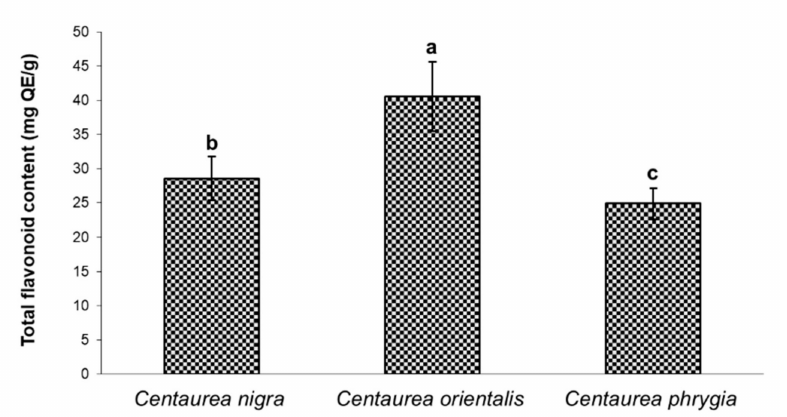
Figure 2. Total flavonoid content (mg quercetin equivalent (QE) per gram of extract) of three Centaurea species. The data represent the mean ± standard deviation of three replicates. Different letters above bars indicate significant differences at p < 0.05 (Tukey LSD test).